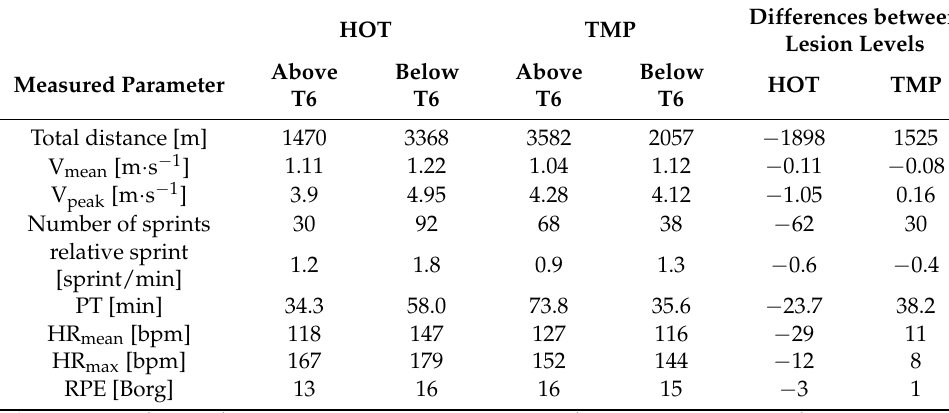
Differences between HOT TMP Lesion Levels Above Below Above Below HOT TMP T6 T6 T6 T6